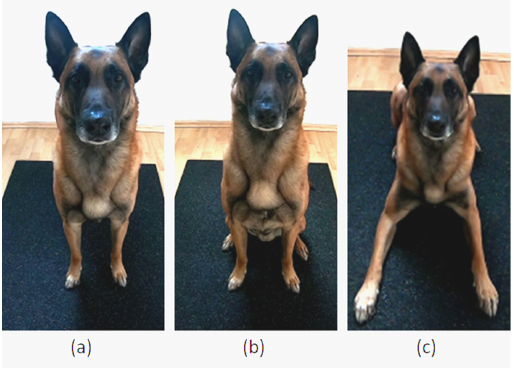
Figure 3. ( a ) Condition 1: Stand position. ( b ) Condition 2: Sit position. ( c ) Condition 3: Lying position. Hurdle Test